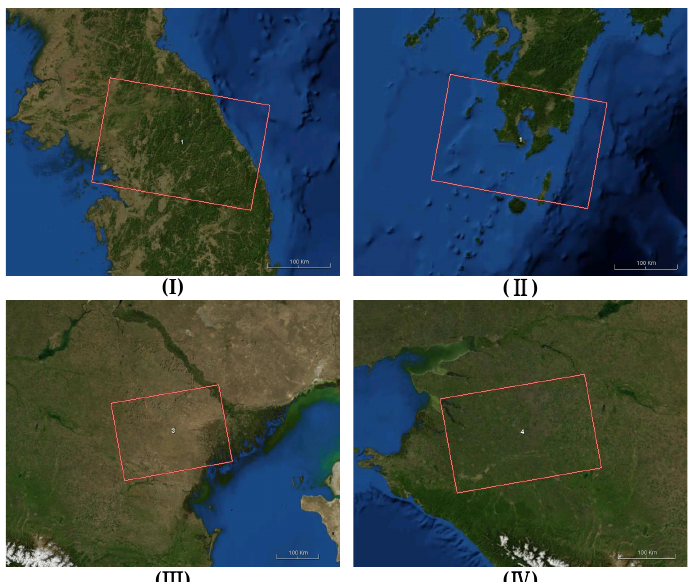
Figure 8. Geographical location description for measured data, where ( I ) in the region of the Korean Peninsula, ( II ) in the sea and islands off Nagasaki, Japan, ( III ) in Astrakhan, Russia, and ( IV ) in Krasnodar Krai, Russia. The red box indicates the interfered area, with a unit length of 100